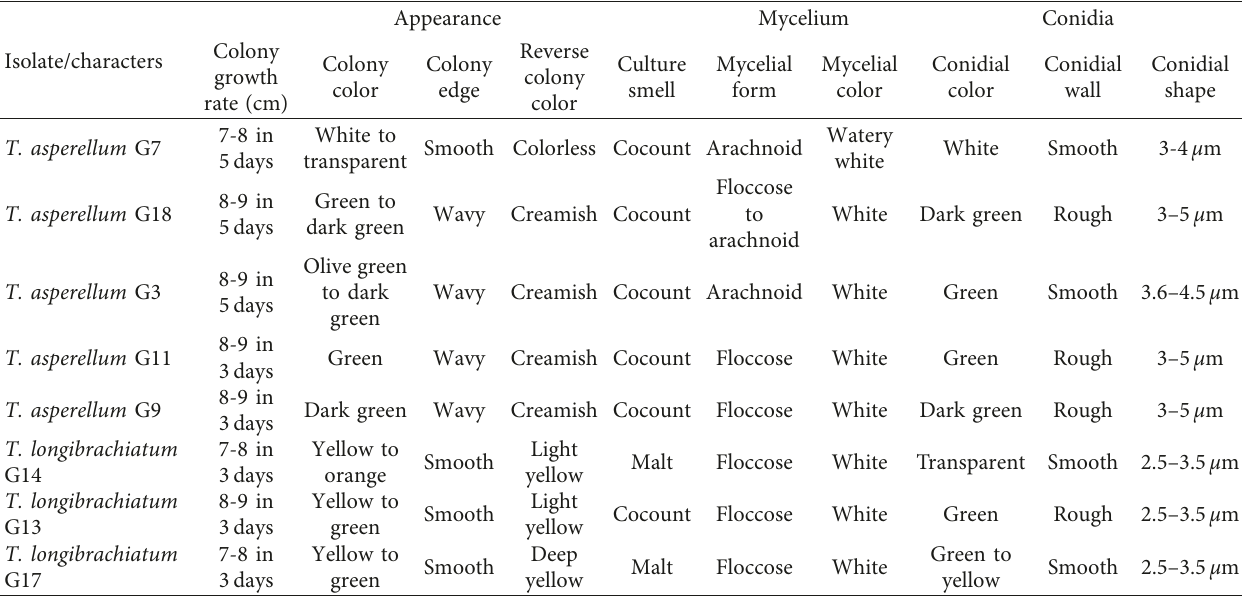
Table 2: Morphological characters of Trichoderma selected strains grown on PDA Petri dish and incubated at 27 ° C for 4-5days.